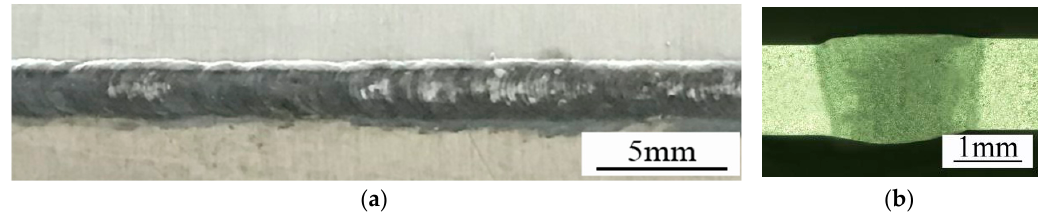
Figure 8. Weld surface and cross section morphology. ( a ) Weld surface; ( b ) Cross section.